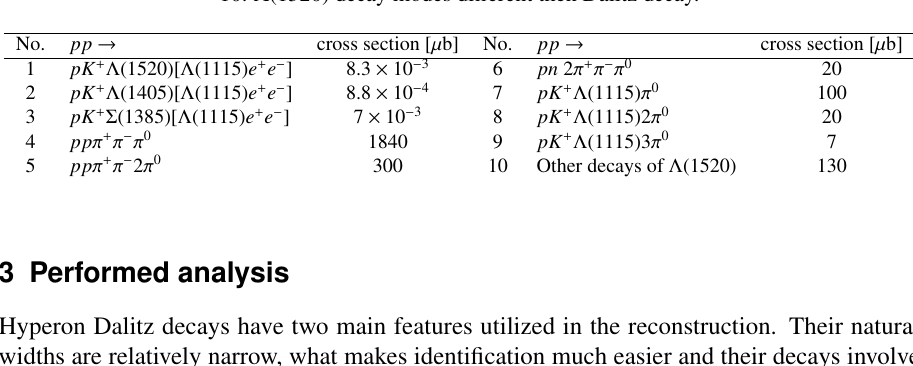
Table 1. List of simulated reactions. Rows from 1 to 3: signal channels (including BR for Dalitz decay), 4-10: background channels. Background reactions are divided into three groups, 4-6: multiple pion production with at least one π 0 , 7-9: Λ (1115) associated with di-lepton source, 10: Λ (1520) decay modes di ff erent then Dalitz